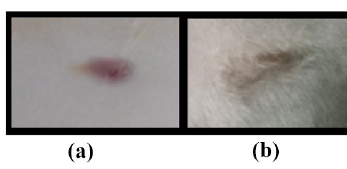
Fig. 19 Wound conditions of mice for 5 days